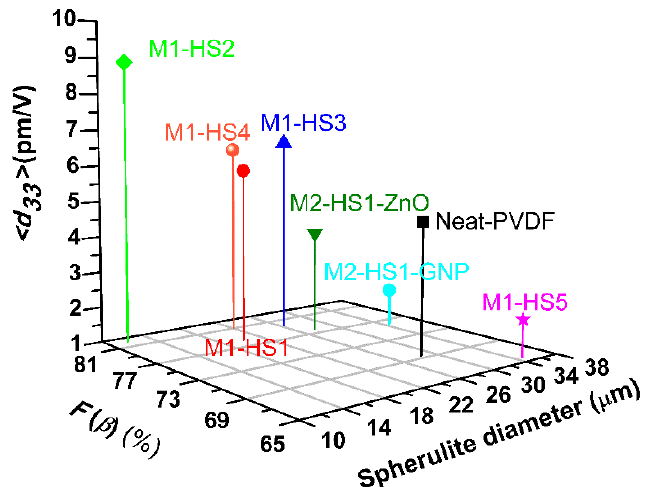
Figure 12. Averaged piezoelectric coefficient, d 33 , vs relative fraction of the β -phase, F ( β ) , and averaged spherulite diameter of the produced samples.